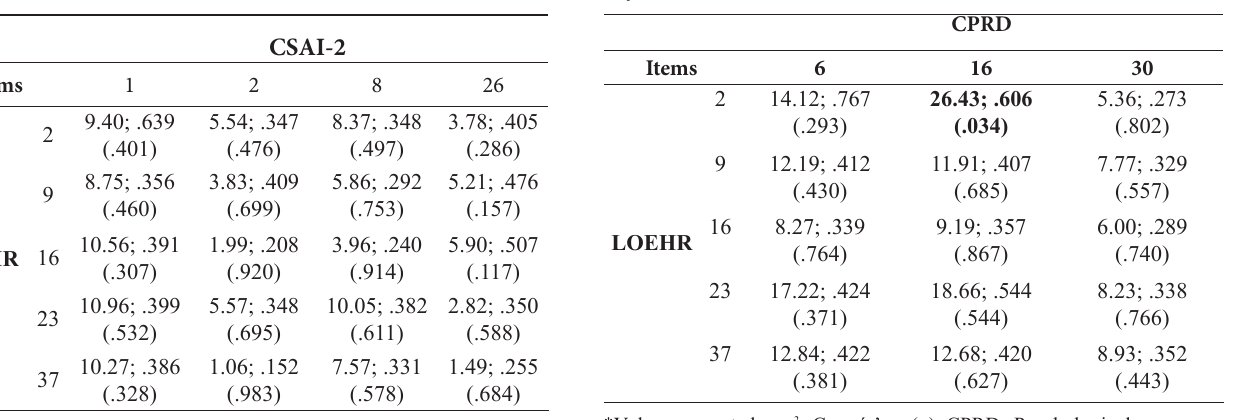
Table 6. Correlation of CSAI-2 and LOEHR items on the variable anxiety.